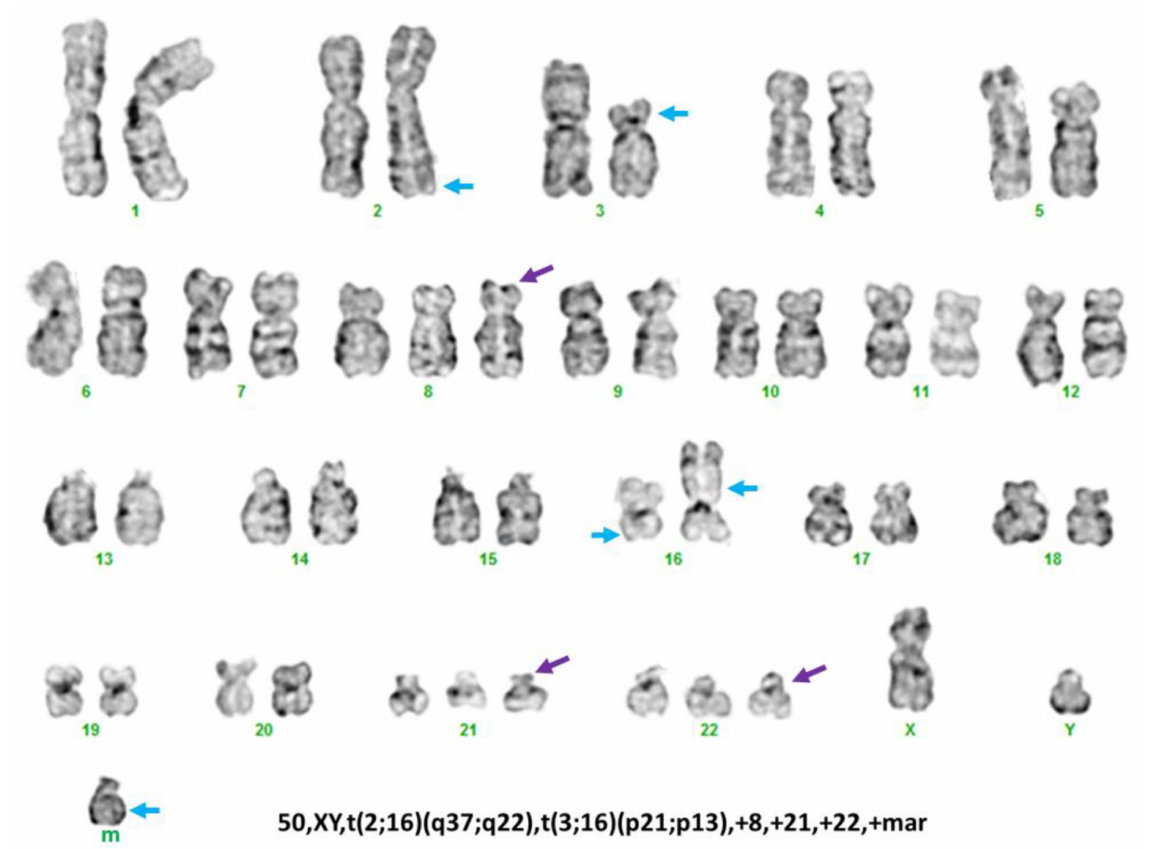
Figure 2. A representative karyogram of complex karyotype identified in our patient. The purple arrows indicate numerical abnormalities (+8, +21, +22) and the blue arrow indicates the structural aberrations involving 2q37, 3p21, 16q22, 16p13, and a marker chromosome.